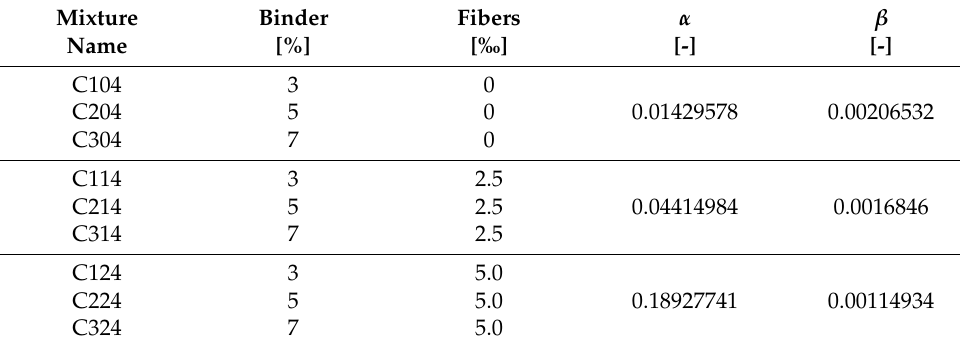
Table 8. Parameters for the exponential function.